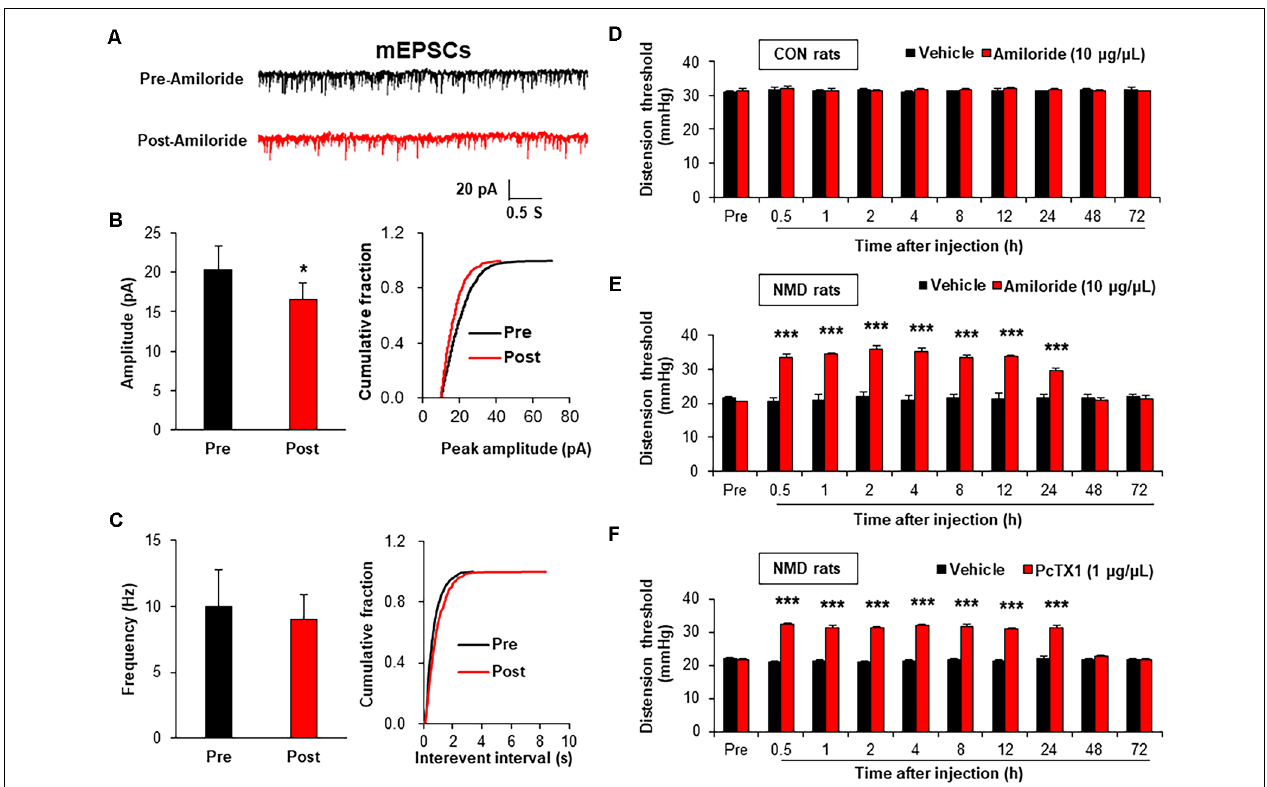
FIGURE 4 | Amiloride reduced spinal mEPSCs and enhanced visceral pain threshold in NMD rats. (A) Representative traces of mEPSCs were recorded in spinal dorsal horn neurons of NMD rats before and after incubation of Amiloride. (B) Bar plots and cumulative probability distributions of the amplitude of mEPSCs recorded in spinal dorsal horn neurons of NMD rats before and after incubation of Amiloride (* P < 0.05, n = 5 cells for each group, two-sample t -test). (C) Bar plots and cumulative probability distributions of the frequency of mEPSCs recorded in spinal dorsal horn neurons of NMD rats before and after incubation of Amiloride ( P > 0.05, n = 5 cells for each group, two-sample t -test). (D) Behavioral changes of CON rats after intrathecal injection of Amiloride (10 µ g/ µ l) for seven consecutive days ( P > 0.05, n = 6 rats for each group, Tukey post hoc test following two-way repeated-measures ANOVA). (E) Behavioral changes of NMD rats after